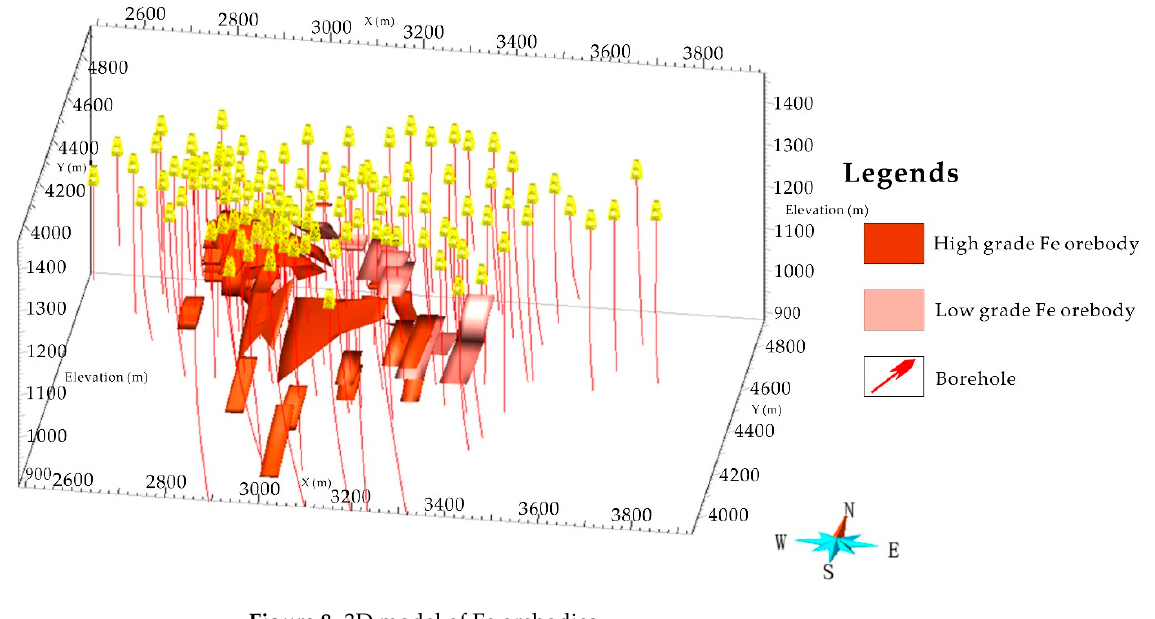
Figure 8. 3D model of Fe orebodies.